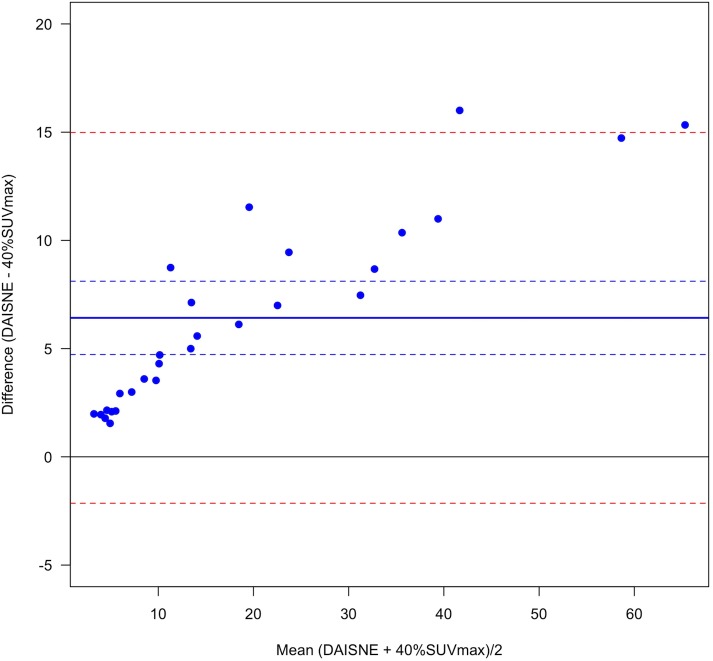
Variability between DAISNE and 40%SUVmax method.Bland-Altman plot. (Solid blue line) Bias. (Dashed blue lines) Bias 95% confidence interval. (Dashed red lines) Difference 95% confidence interval.